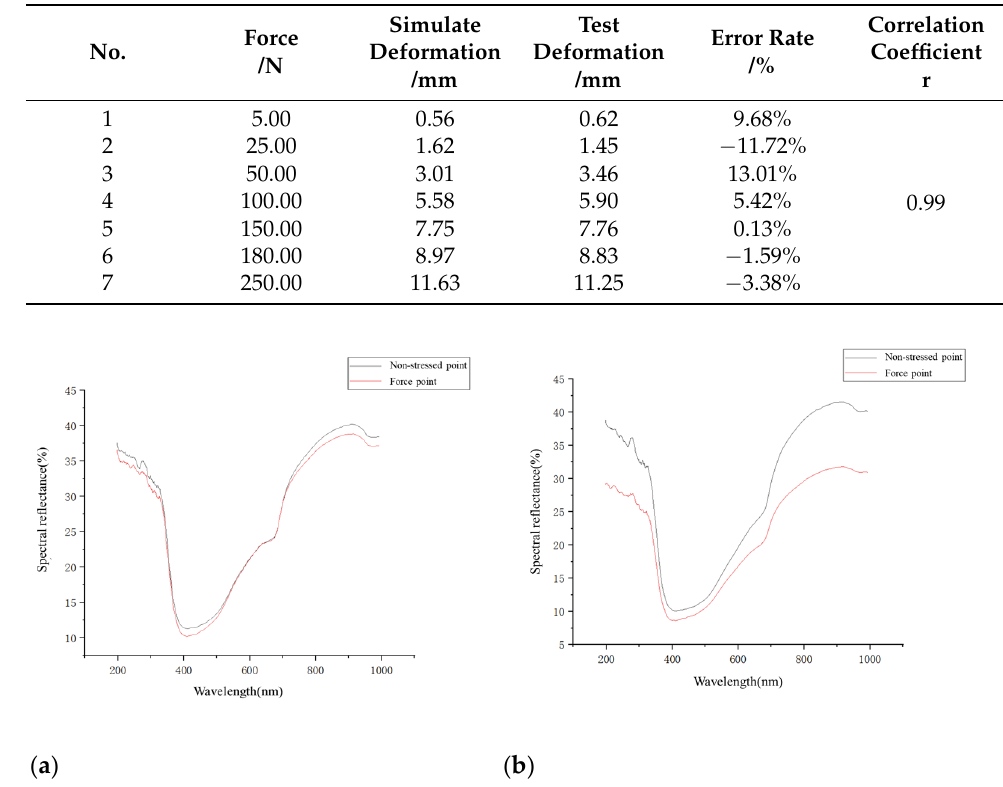
Figure 8. Statistics of different stressed kiwi spectrum tests. ( a ) 5 N; ( b ) 150 N. As shown in Table 5, the reflectivity difference of the damaged point of the kiwifruit increased with the increase in force. When the force was 150 N, the difference value reached 9.84%, and obvious cracks appeared above 180 N, which were obvious damage. So, there was no point in measuring. The hardness test after 72 h is shown in Table 5. Through data analysis, it was found that the force hardness value of about 5 N did not change much, while the hardness of kiwifruit gradually decreased with the increase in force after 25 N. As the force degree of kiwifruit increased from 5 N to 250 N, the hardness value of kiwifruit decreased from 12.06 to about 5.86 kg/cm 2 . It conformed to the cloud stress and strain distribution of kiwifruit in the kiwifruit compression simulation. The authenticity of the hidden injuries in the kiwifruit test detection was verified. Table 5. Kiwifruit hardness test statistics table.